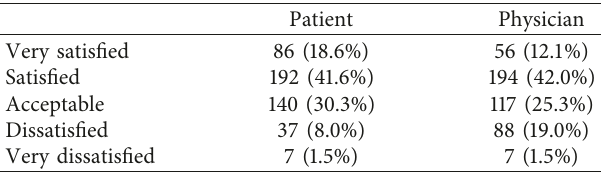
Table 2: Patient and physician assessment of satisfaction with pain control ( n � 462). Data presented as n